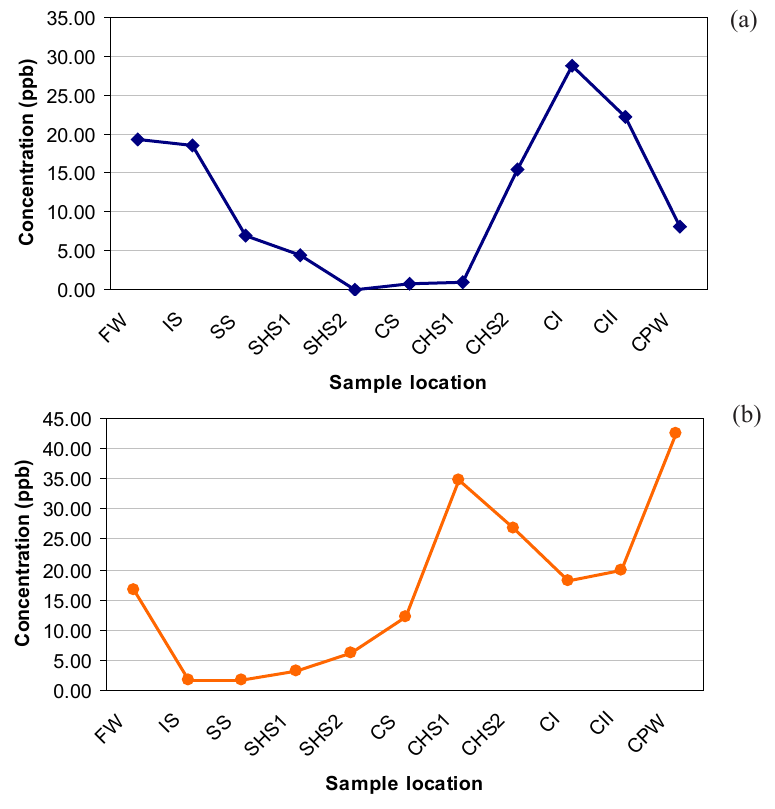
Figure 7. Distribution of iron and copper content depending on the sampling location and operation mode (a) Fe and (b)